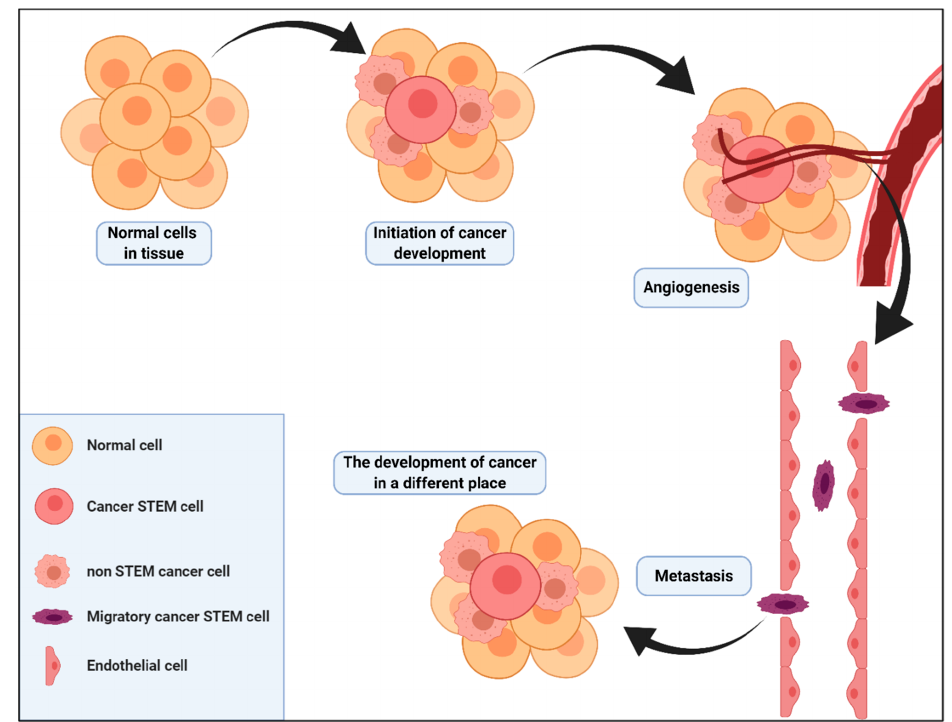
Figure 3. The formation of neoplastic stem cells and the mechanism of cancer formation and its metastases. The development of a tumour is usually sequential. After the appearance of the first neoplastic cells, i.e., both stem cells and nonstem cells, the tumour develops gradually. In the next stage, the process of angiogenesis begins, and as a result of the formation of blood vessels, the invasive cells can move to other regions of the body.